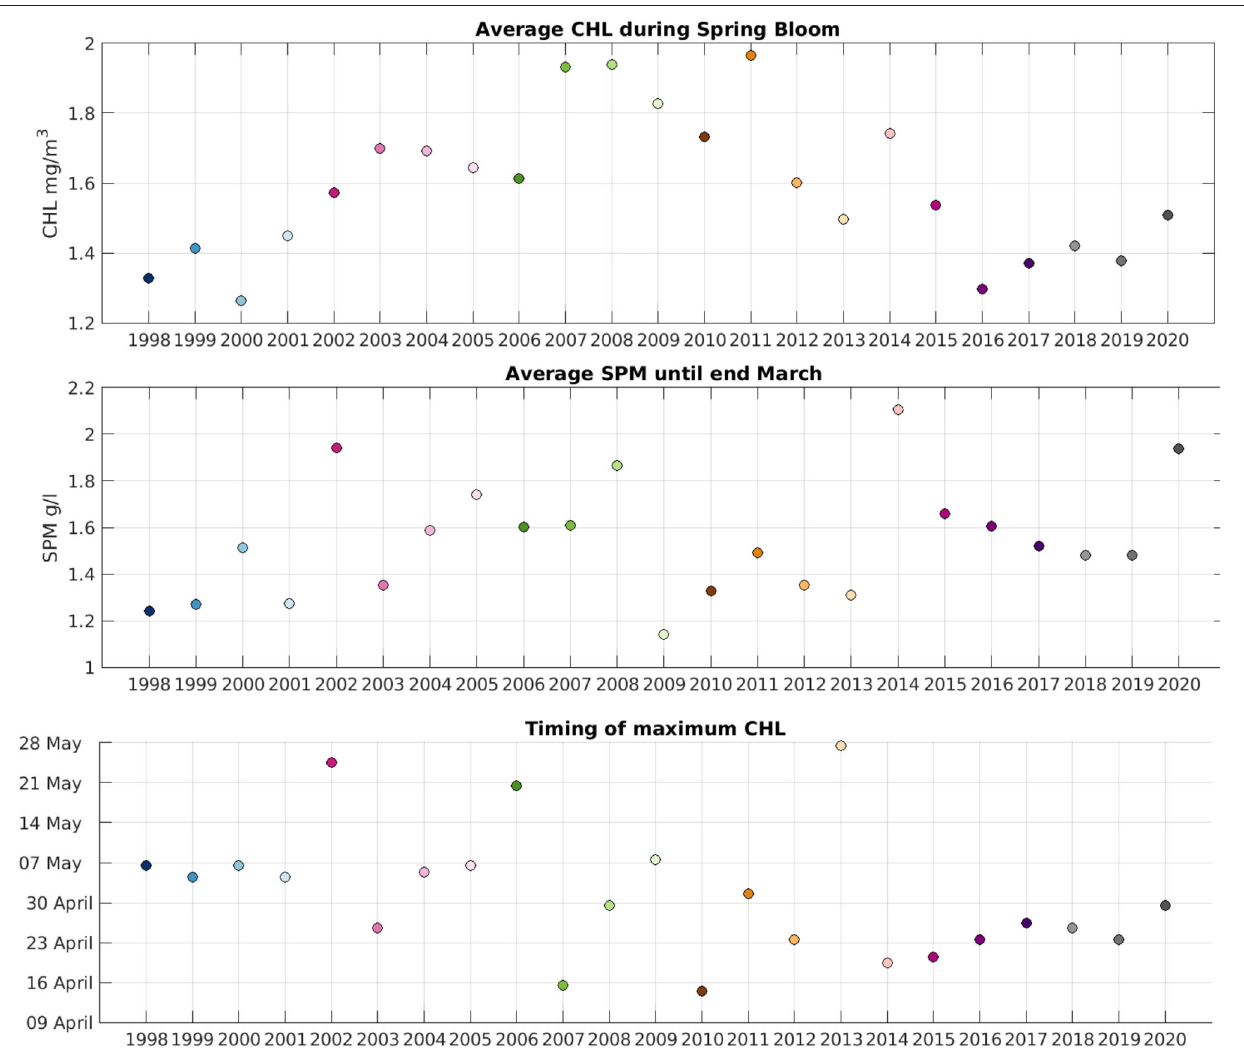
FIGURE 12 | (Top) Average CHL during the spring bloom period each year. (Middle) Average SPM during February and March. (Bottom) Time at which the maximum CHL concentration is reached each year.